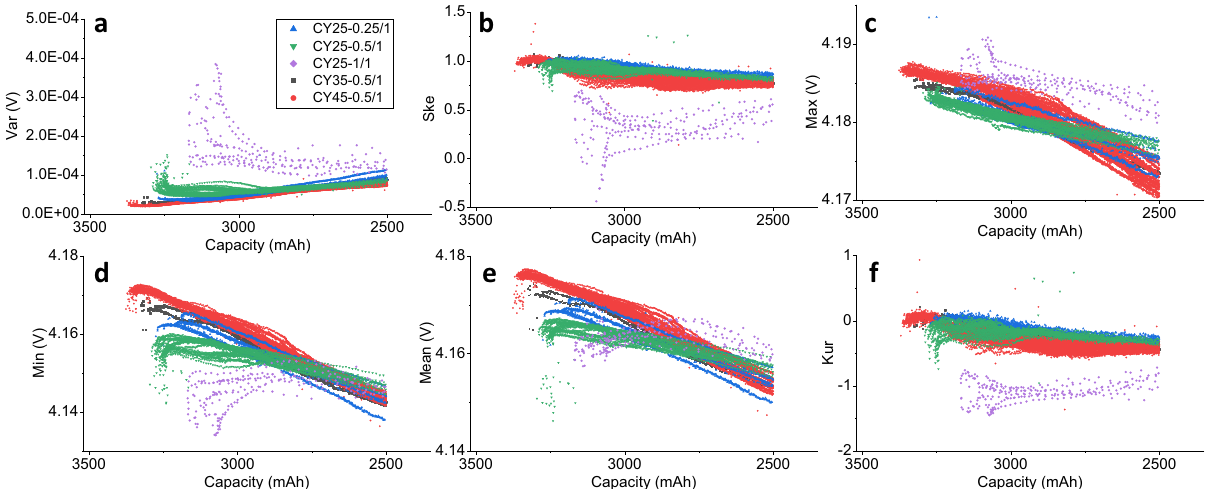
Fig. 2 Extracted features from the voltage relaxation curves as a function of battery capacity for NCA cells. ( a ) Variance (Var), ( b ) skewness (Ske), ( c ) maxima (Max), ( d ) minima (Min), ( e ) mean (Mean), and ( f ) excess kurtosis (Kur). Feature changes between 3500 mAh and 2500 mAh (71% of nominal capacity) for NCA cells are shown to be consistent with the used datasets. The mathematical description of the six features is depicted in Supplementary Table 5. respect to the relaxation time, the voltage drops initially fast and cycle number, and vice versa. Both Ske and Kur are normalized then gradually slows down. The Max in Fig. 2c presents a using Var, they are used to describe the shape of the monotonous decrease of the maximum voltage versus capacity corresponding voltage curve. The Ske in Fig. 2b is positive for drop for all cycling conditions. The Min and Mean fi rst increase almost all cycling conditions, indicating that more than half of the and then decrease versus the capacity reduction as displayed in sampled voltage data are below the average voltage (Mean), which Fig. 2d, e, respectively. The Kur shown in Fig. 2f is the excess corresponds to the shape of the relaxation voltage curve, i.e., with NATURE COMMUNICATIONS| (2022) 13:2261